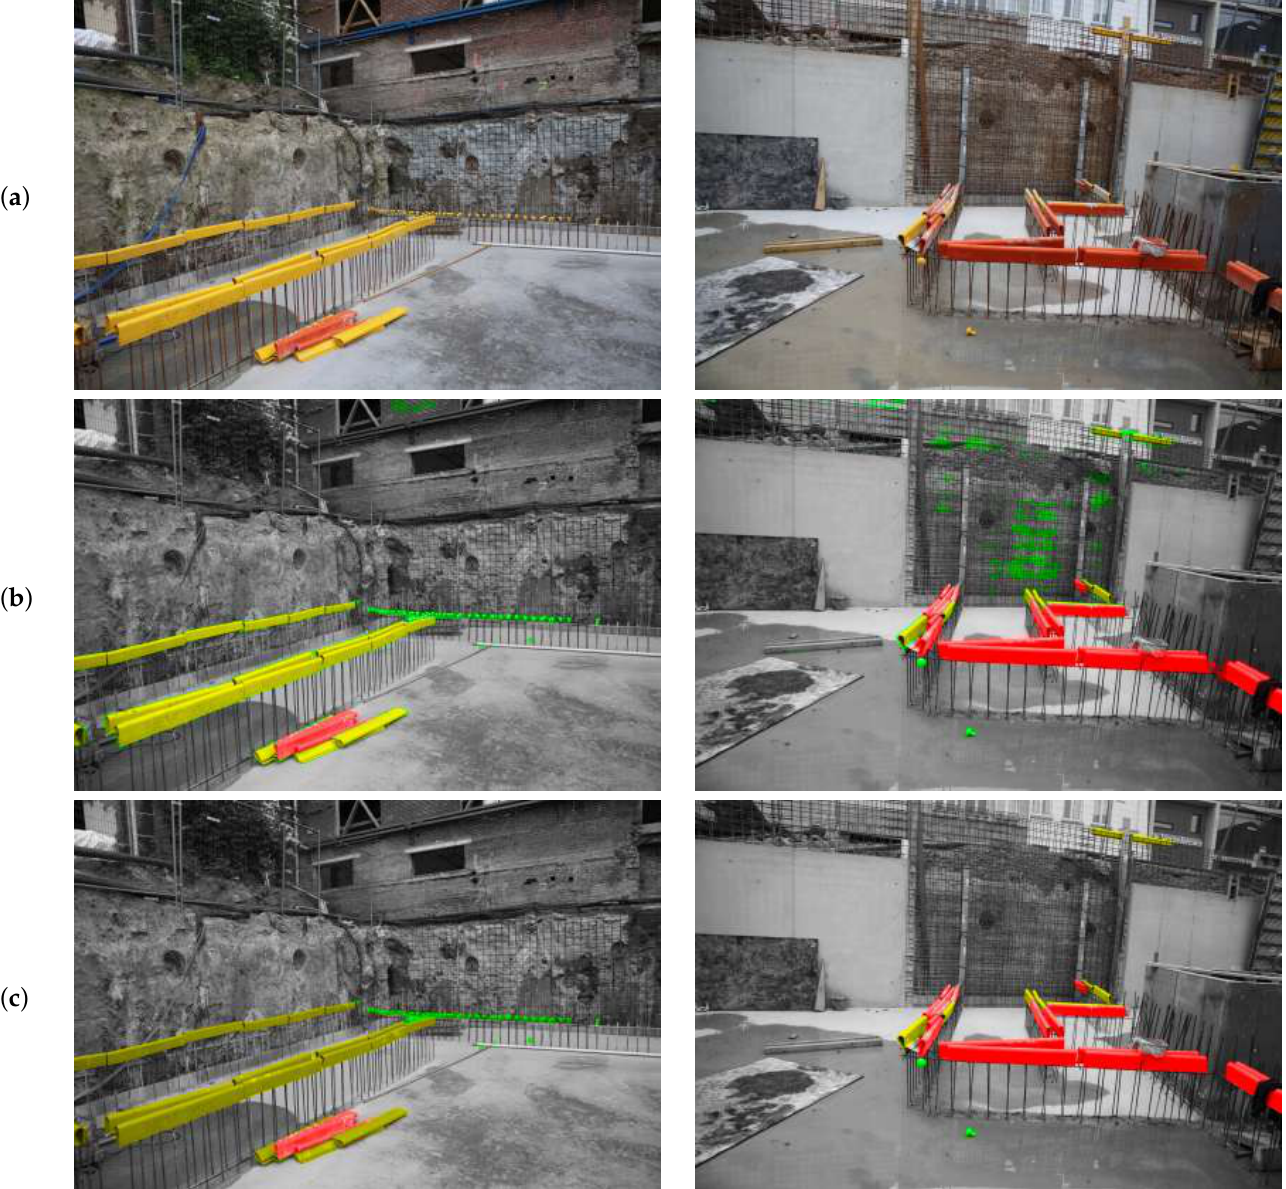
Figure 8. Concatenated predictions of two trained CCT frameworks on the two training images in D l . ( a ) Input images. ( b ) Prediction of the first run of CCT_ D w with crop size 304 × 504 (mIoU: 61.5 on D v ). ( c ) Prediction of the third run of CCT_ D w with crop size 320 320 (mIoU: 69.1 ). All rebar covers are identified correctly. False positives occur in ( b ) in the left image on the brick wall above the excavation and on the right image in the rebar mesh against the brown earth wall.